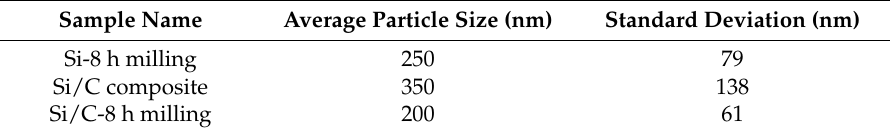
Figure 2. FE-SEM images of the Si and Si/C composite powders: ( a ) Si raw powder; ( b ) Si milled for 8 h; ( c ) Si/C powder after carbonization; and ( d ) Si/C milled for 8 h. Table 1. Average particle size and standard deviation of the as milled Si and Si/C powders.